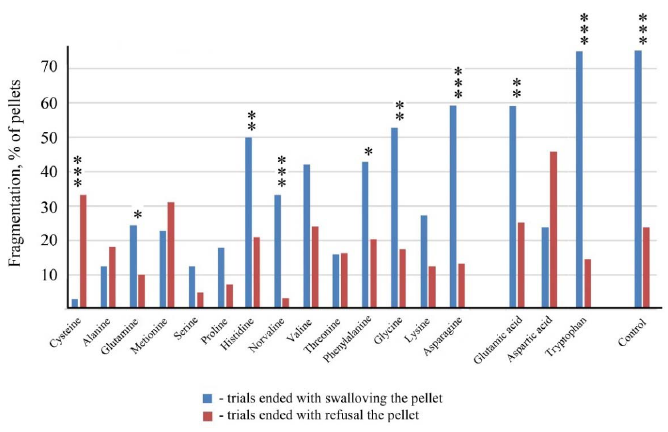
Figure 10. Retention time during all grasps of pellets flavored with amino acids ended with swallowing or refusal of the pellet by barramundi Lates calcarifer . Differences between trials performed with each amino acid are significant at p < 0.001 for all substances (Mann–Whitney U ‐ test). Whiskers are the s.e.m.